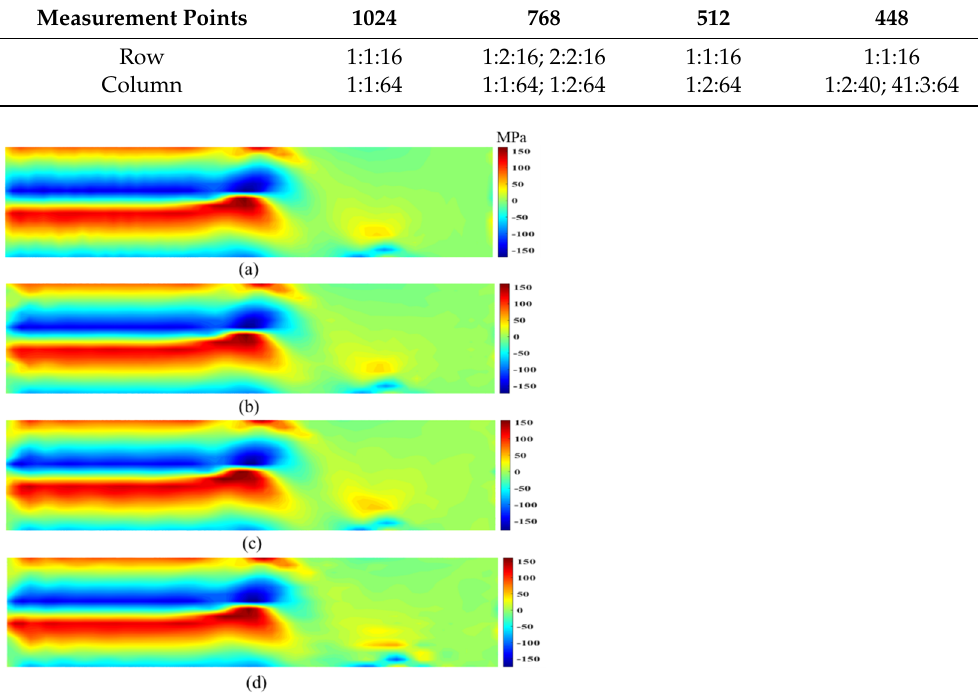
Figure 6. Residual stress fields ( σ x ) by inverse identification: ( a ) 1024 measurement points, ( b ) 768 measurement points, ( c ) 512 measurement points and ( d ) 448 measurement points.